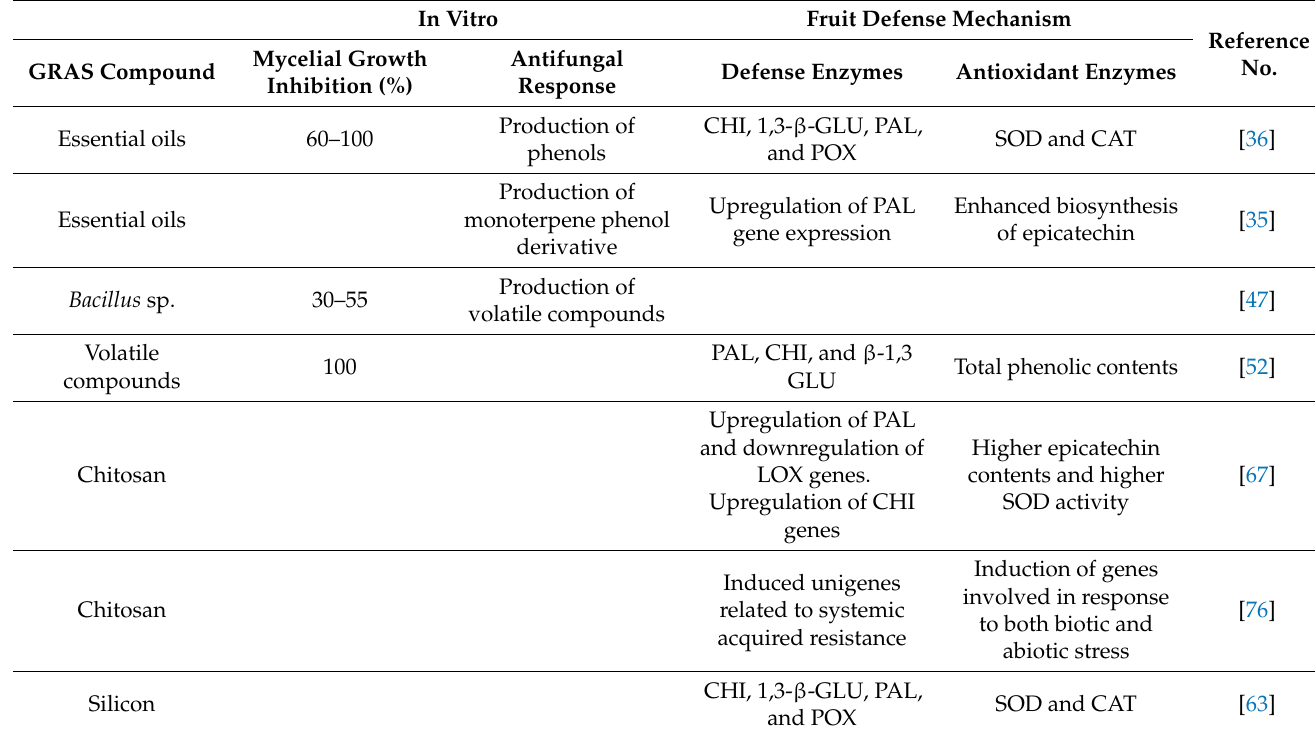
Table 1. Main effects of GRAS application in vitro and on avocado fruit defense mechanism during storage. In Vitro Fruit Defense